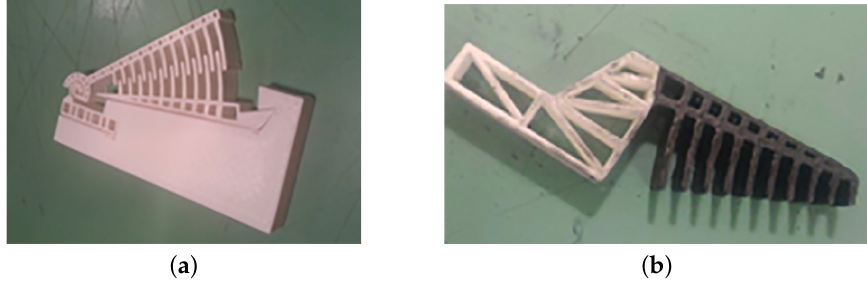
Figure 7. Unsuccessful comb drive at the macroscale: ( a ) bulk; and ( b ) covered by conductive paste.